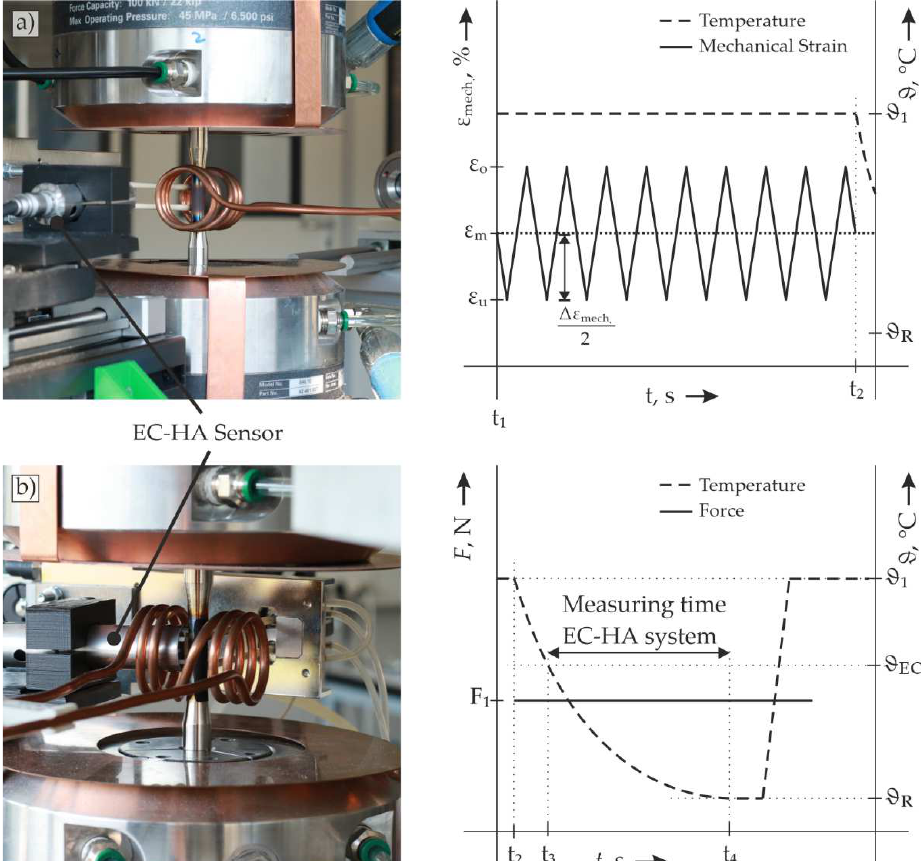
Figure 2. Modified LCF test procedure with combined EC-HA measurement: ( a ) strain-controlled LCF at a constant temperature of ϑ 1 with EC-HA sensor in park position, ( b ) EC-HA sensor in measurment position recording the electromagnetic characteristics of the specimen between ϑ EC and ϑ R under stress-free conditions (F 1 = 0). Table 1. Test parameters of the modified isothermal LCF